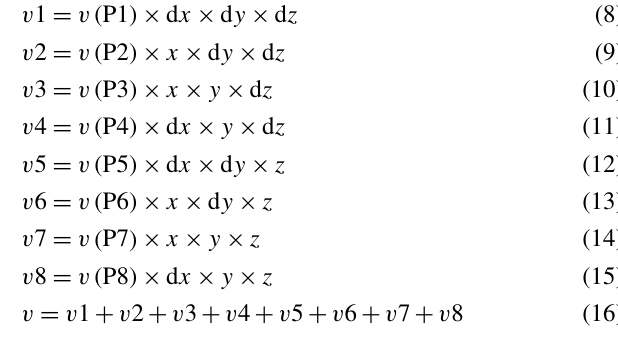
Figure 7. 3D interpolation cube. Points are defined by their grid position (lon*, lat*, p ∗